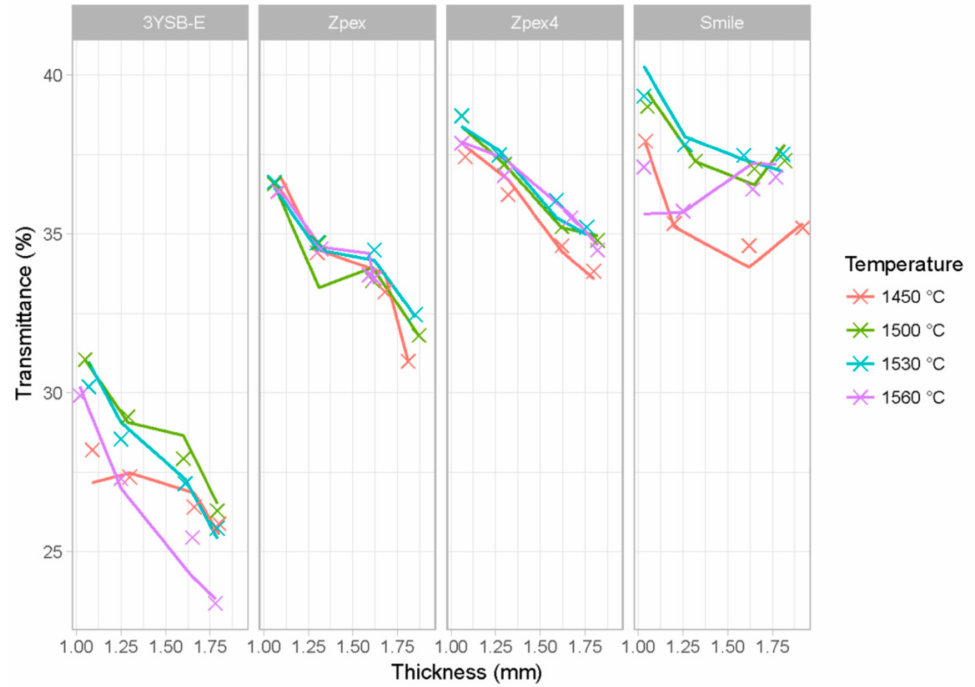
Figure 5. Results adjusted by the model (lines) and observations determined in the experiments (asterisks).